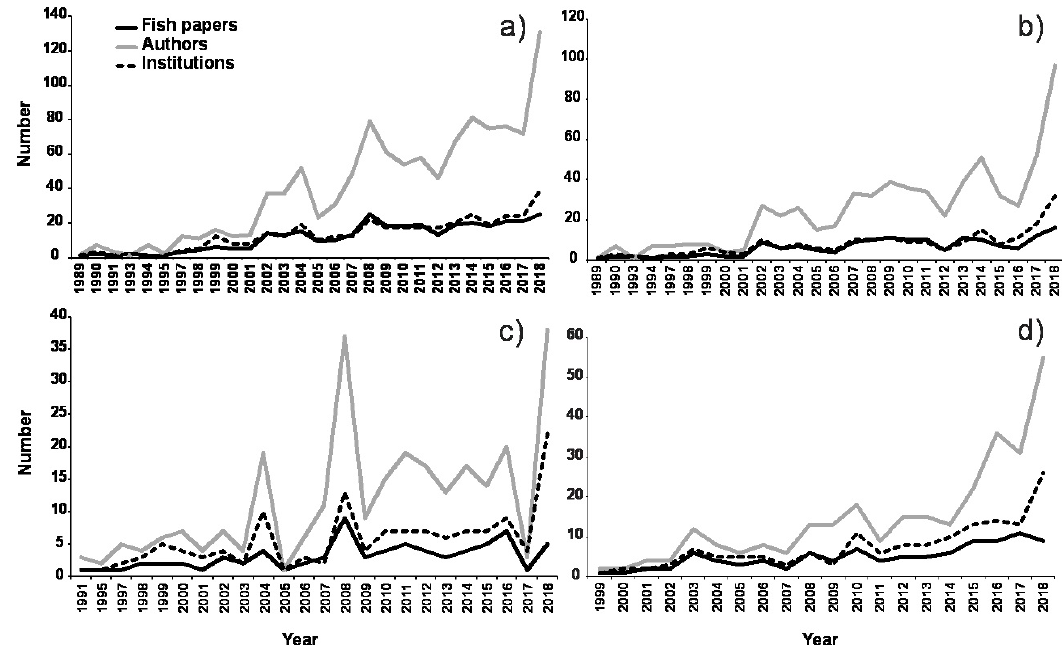
Figure 1. Temporal series of the number of freshwater fish papers, authors and institutions by all basins combined (a), Paraná (b), Araguaia (c) and Tocantins River basin (d) at Goiás